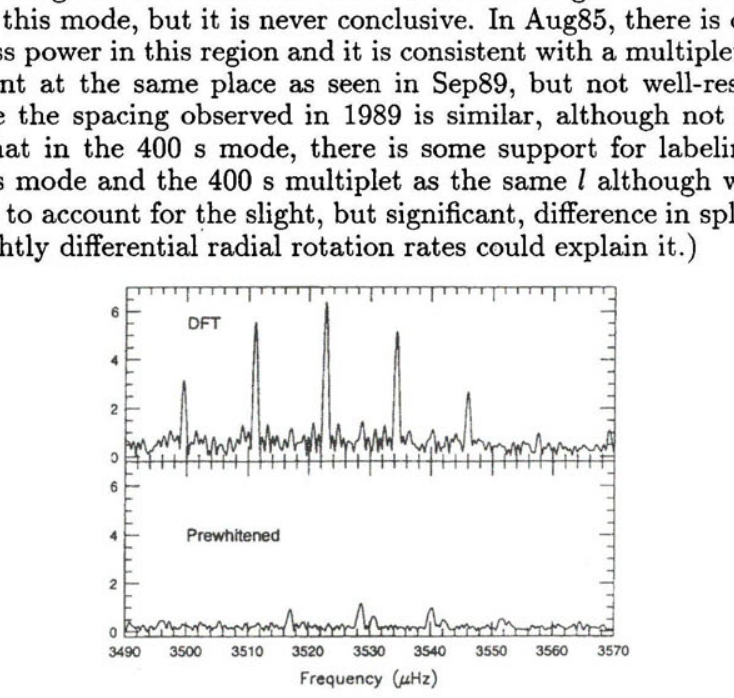
Fig. 7. Fourier transform of the 284 s region of G 29-38 in